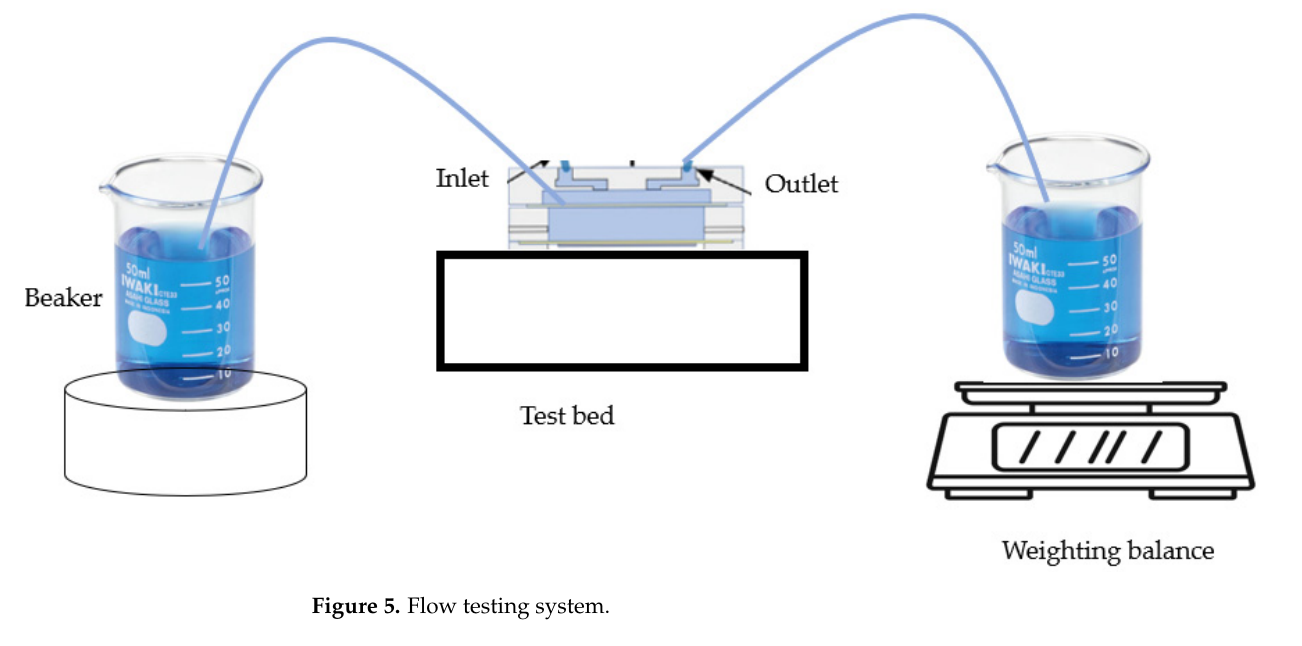
Figure 5. Flow testing system.